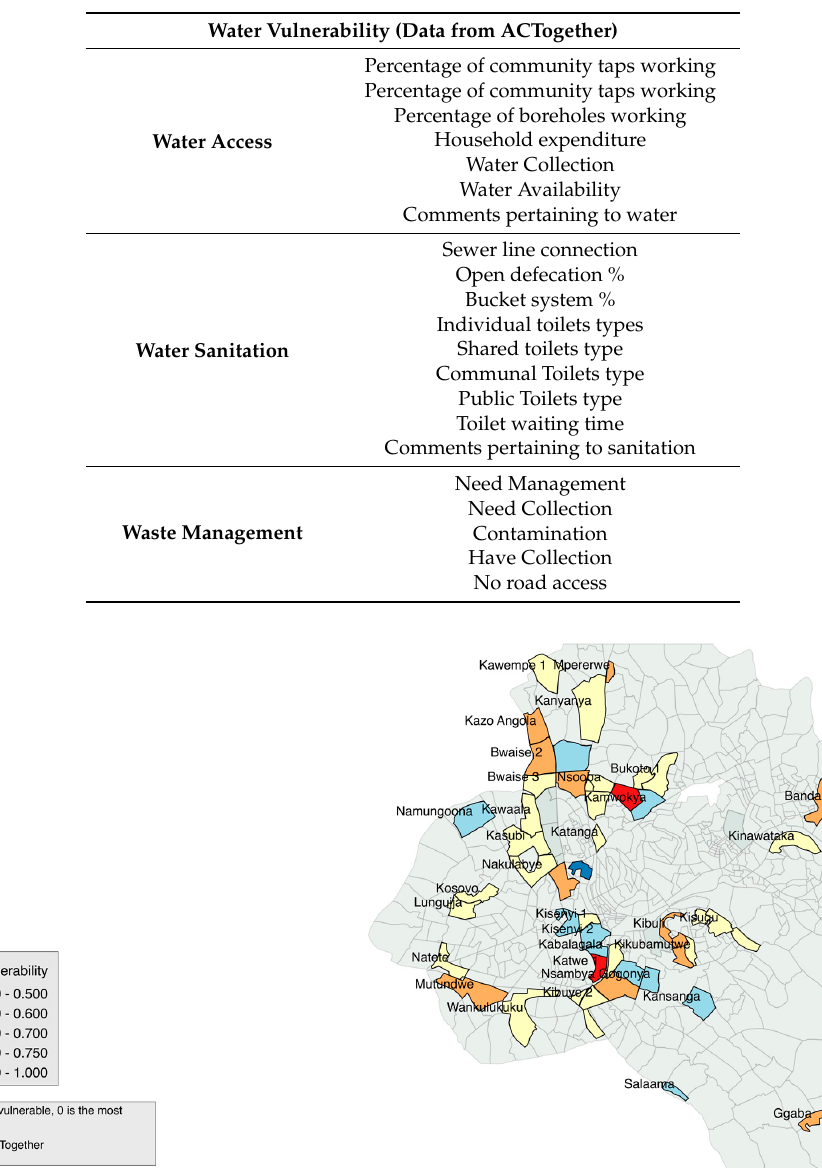
Table 1. Variables used to calculate water Vulnerability. Data are normalized on a scale from 0–1 and then averaged to get the water vulnerability score.